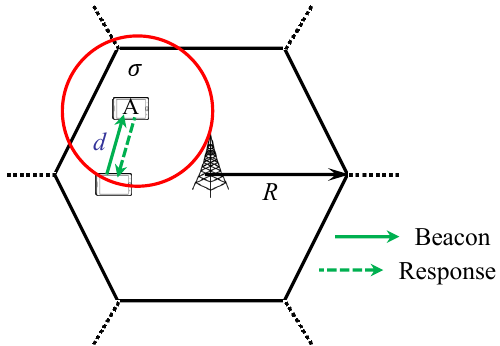
Figure 5. System model for